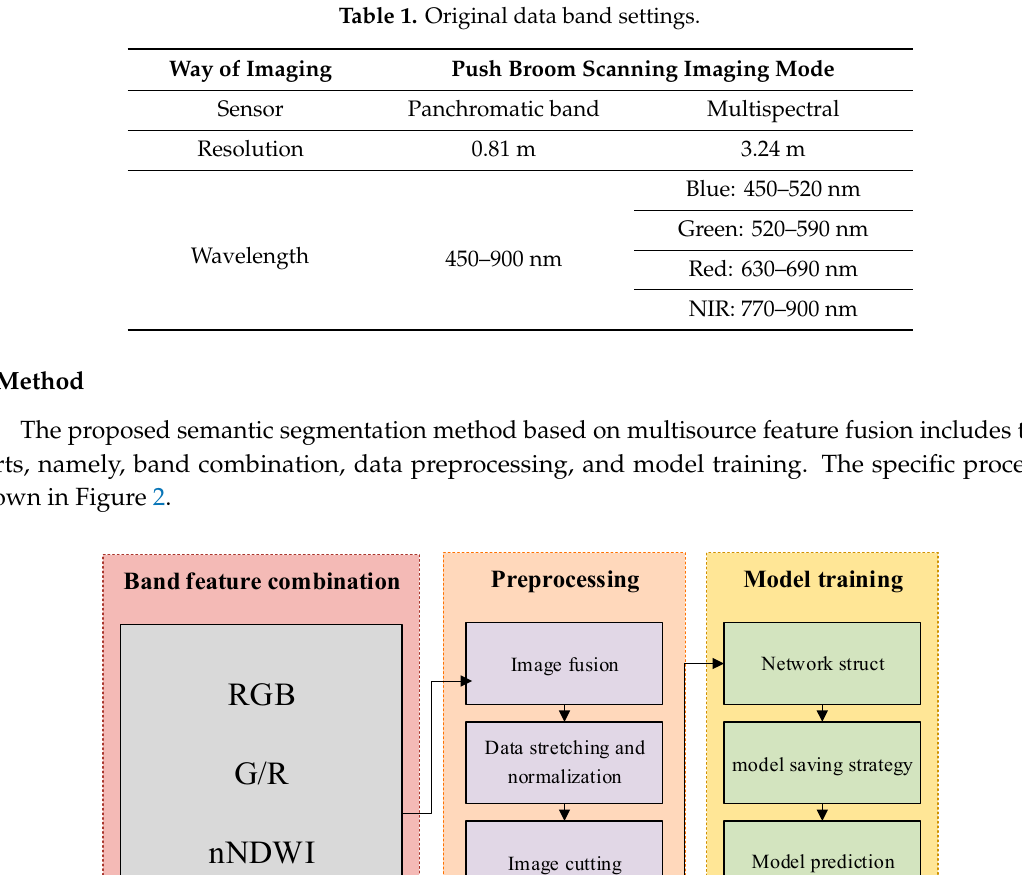
Figure 1. Study area and GF-2 image. ( a ) Study area. ( b ) GF-2 image. Table 1. Original data band settings.